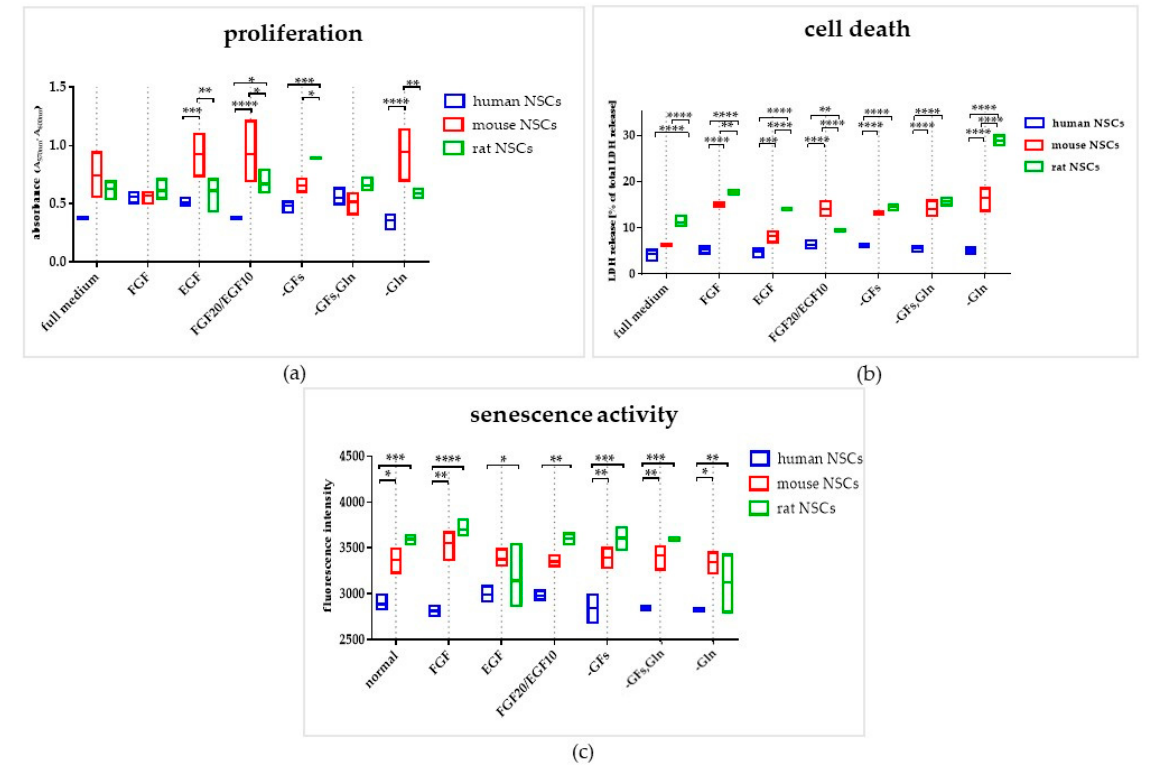
Figure 7. The influence of the medium composition on proliferation, viability, and senescence of 2D NSCs. ( a ) Proliferation of NSCs on Day 7 of culture. ( b ) Cell death of NSCs after Day 7 of culture. ( c ) Senescence activity of NSCs after Day 7 of culture. Cell culture conditions: 5% O 2 , 5% CO 2 , 37 °C, n = 3. The results of all presented experiments are expressed as mean values of three experiments ± SEM. The differences were considered statistically significant when the p -value < 0.05. Statistical significance level: * for 0.01 < p < 0.05, ** for 0.001 < p < 0.01, *** for 0.0001 < p < 0.001, and **** for p < 0.0001.